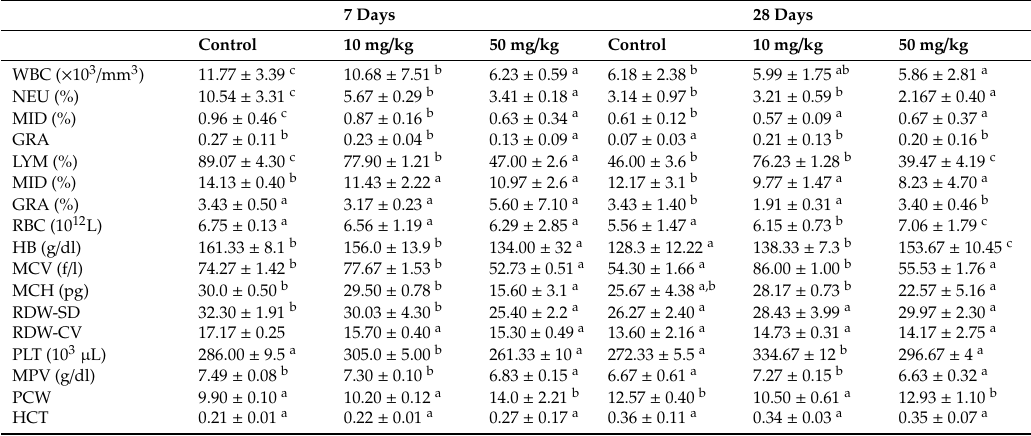
Table 3. E ff ects of sub-dermal administration of Ag-NP on hematological parameters in rats.